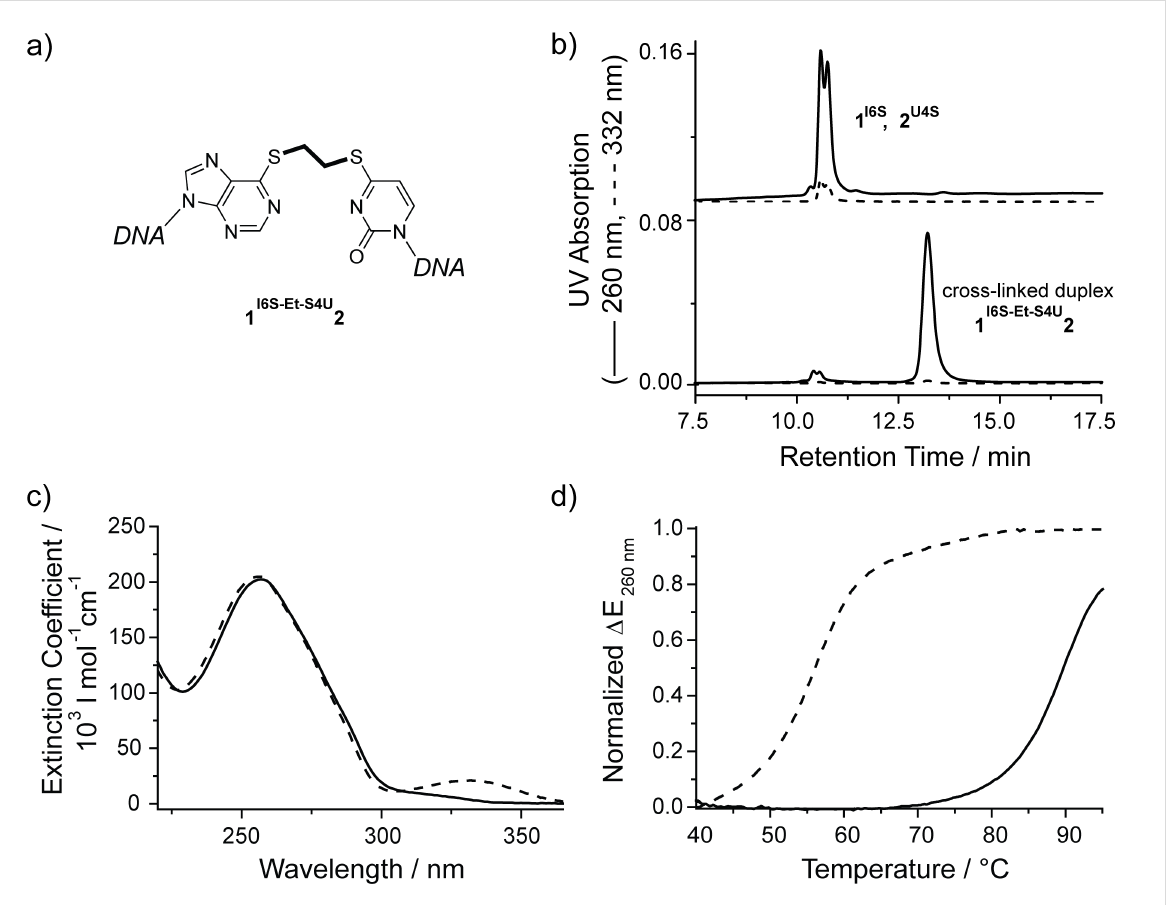
Figure 2: Characterization of HPLC-purified cross-linked duplex 1 I6S-Et-S4U 2 (a) by denaturing anion exchange HPLC (b, bottom) in comparison to the non-linked parent duplex (b, top). Alkylation at the sulfur atoms within the thio-nucleobases is confirmed by the wavelength shift and strong intensity reduction of the absorption band above 300 nm in the UV spectrum (c, solid) compared to the spectrum of 1 I6S ∙ 2 U4S (dashed). The thermal stability of the cross-linked duplex 1 I6S-Et-S4U 2 (d, solid) is drastically increased compared to 1 I6S ∙ 2 U4S